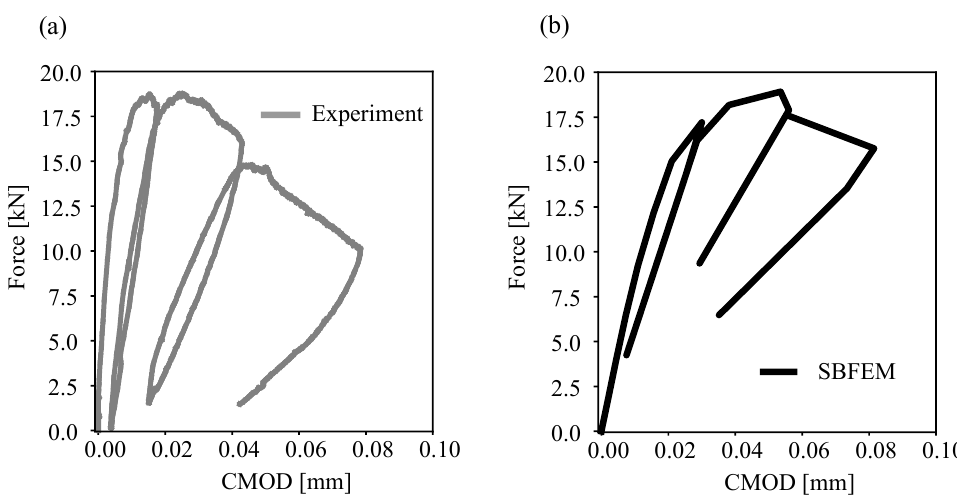
Figure 9. Comparison of numerical predictions ( a ) and experimental measurements ( b ) of Cyclic- CMOD curves for the single-notched three-point bending test.